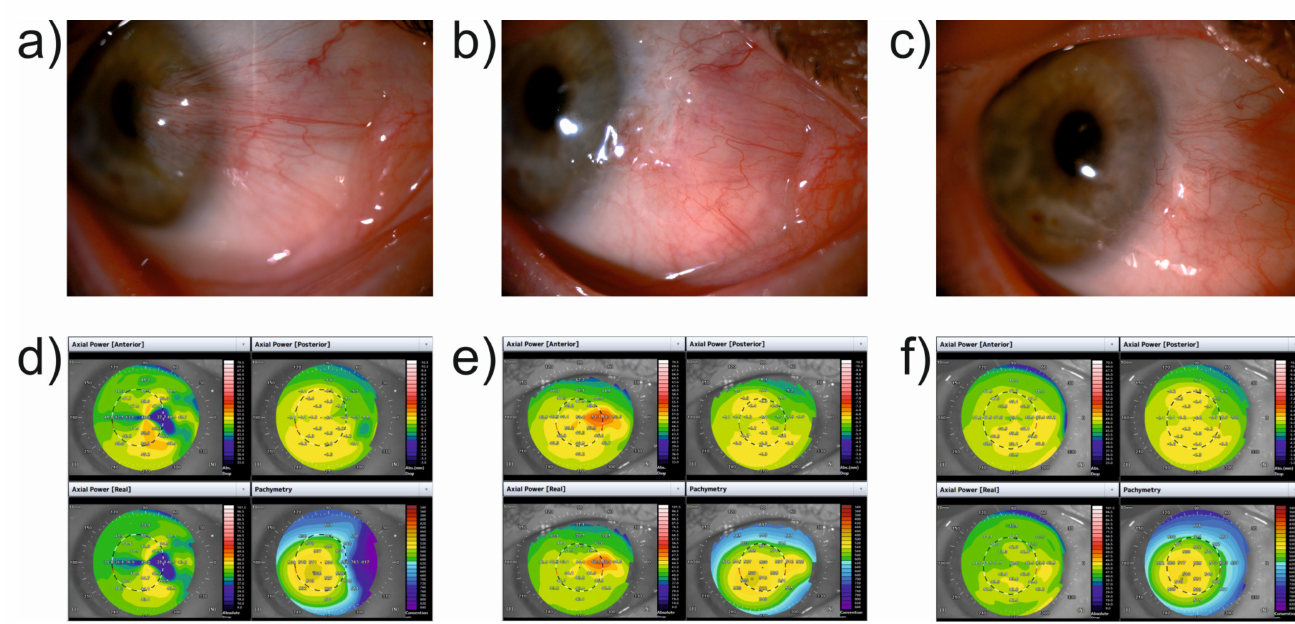
Figure 2. Anterior segment photography taken preoperatively at ( a ) 1 month ( b ) and 6 months ( c ) after pterygium removal by autologous conjunctival transplantation with human fibrin tissue glue; swept-source anterior segment optical coherence tomography taken preoperatively at ( d ) 1 month ( e ) and 6 months ( f )